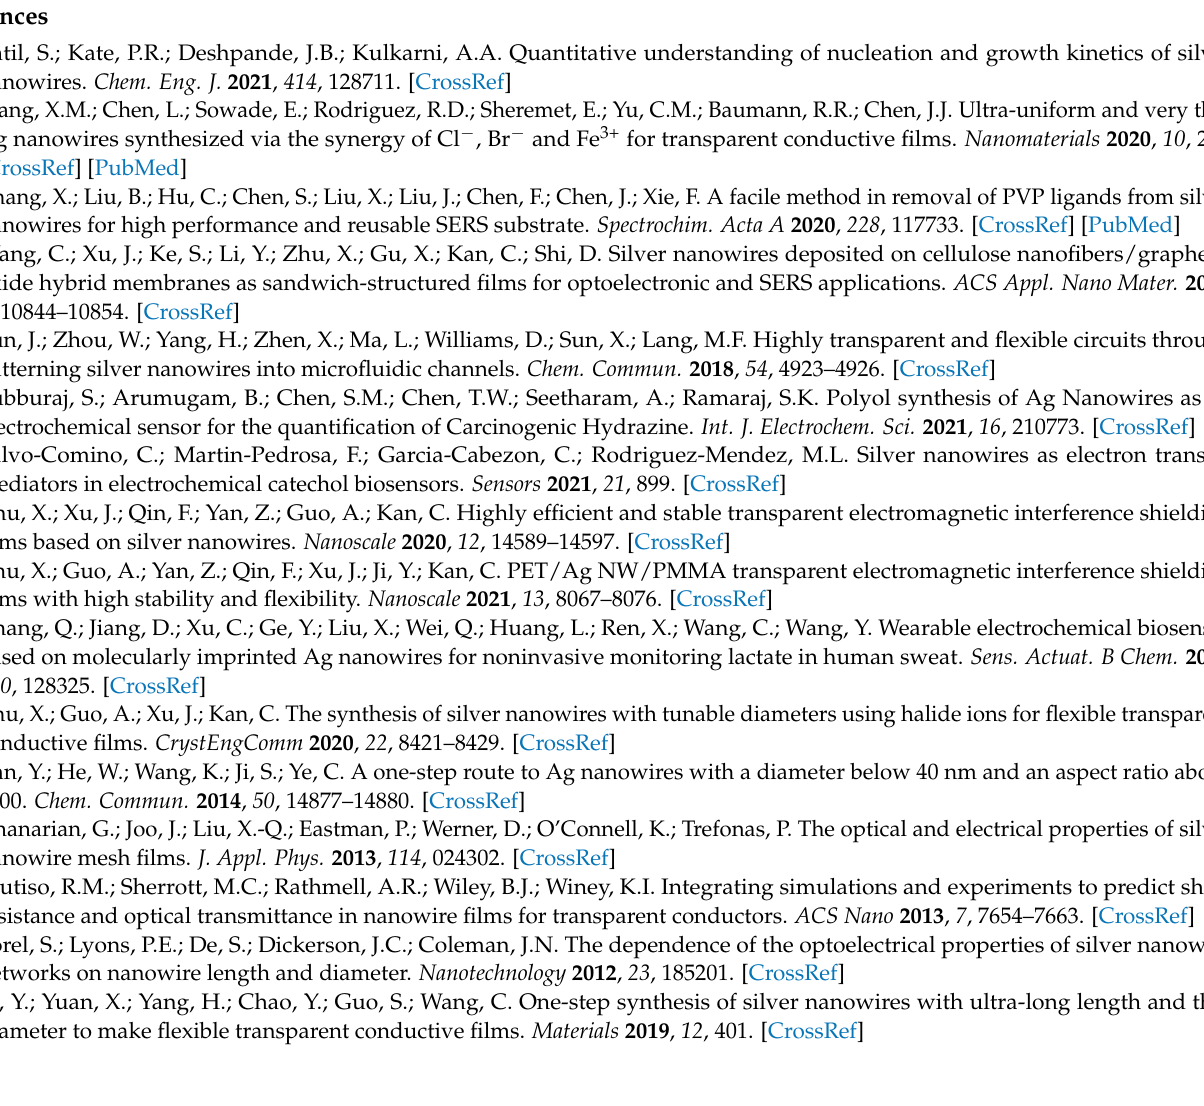
Figure S2: TEM images of AgNWs obtained with 66.7% Br − and 33.3% Cl − . (a,b) Low magnification image of AgNWs; (c) high magnification image of AgNWs; (d) a zoom-in TEM image taken from the marked square area in image (c), demonstrating the lattice fringe with spacing of 0.237 nm; Table S1: The number of valence electrons for different halogens on Ag(100) crystal face in AgNWs; Table S2: The number of valence electrons for different halogens on Ag(111) crystal face in